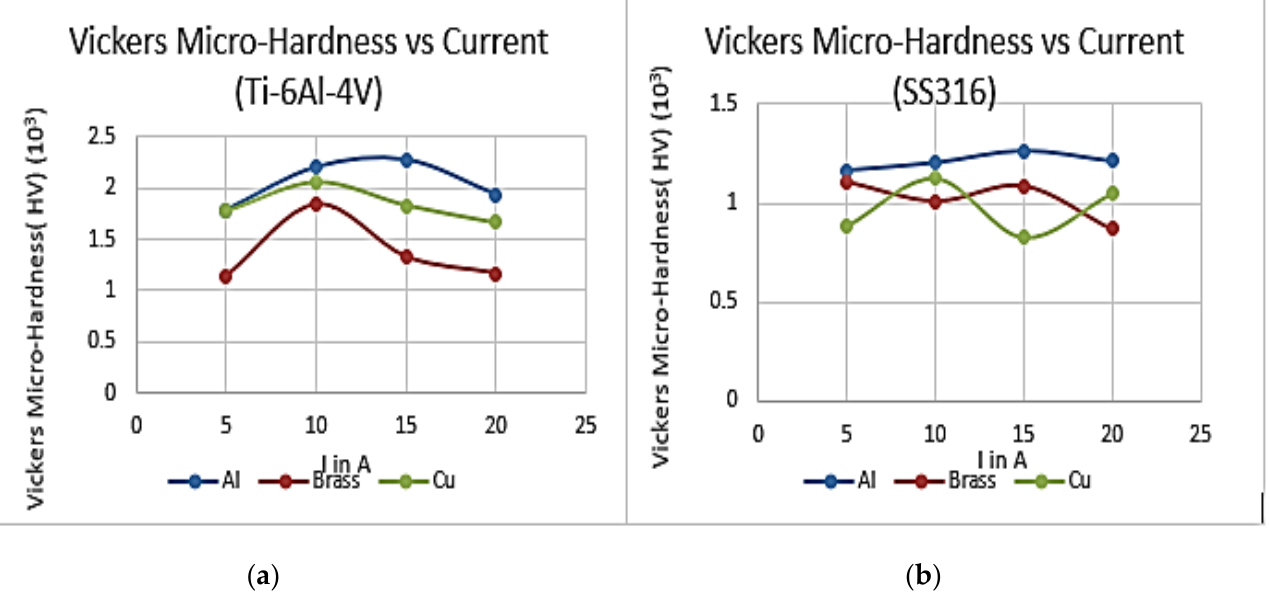
Figure 11. Variations of VH for ( a ) Ti - 6Al - 4V and ( b ) SS 316 using different tools. Figure 7b represents the variations of MRR of SS316 material at different currents using different tool materials. It is shown in the above graph that the MRR values drastically increase with current when the Cu tool is used compared to Al and brass tools. Hence, Cu is a best tool material among these three tools with regards to MRR of the work piece material. The reason is same as for